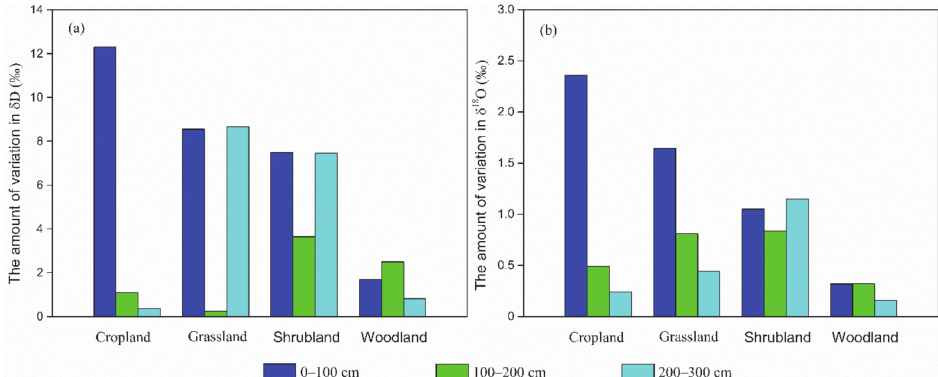
Figure 3. The amount of variation in δ D and δ 18 O in different soil layers under the four land uses considered in the current study (( a ) δ D, ( b ) δ 18